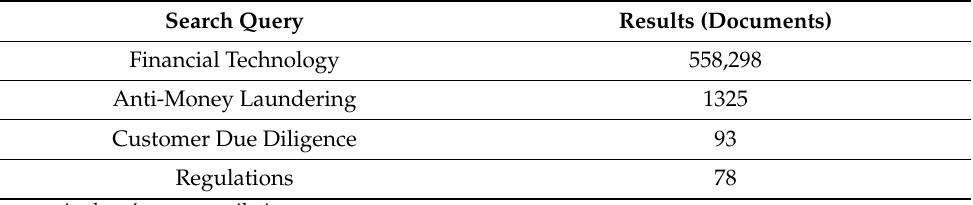
Table 1. Search Query